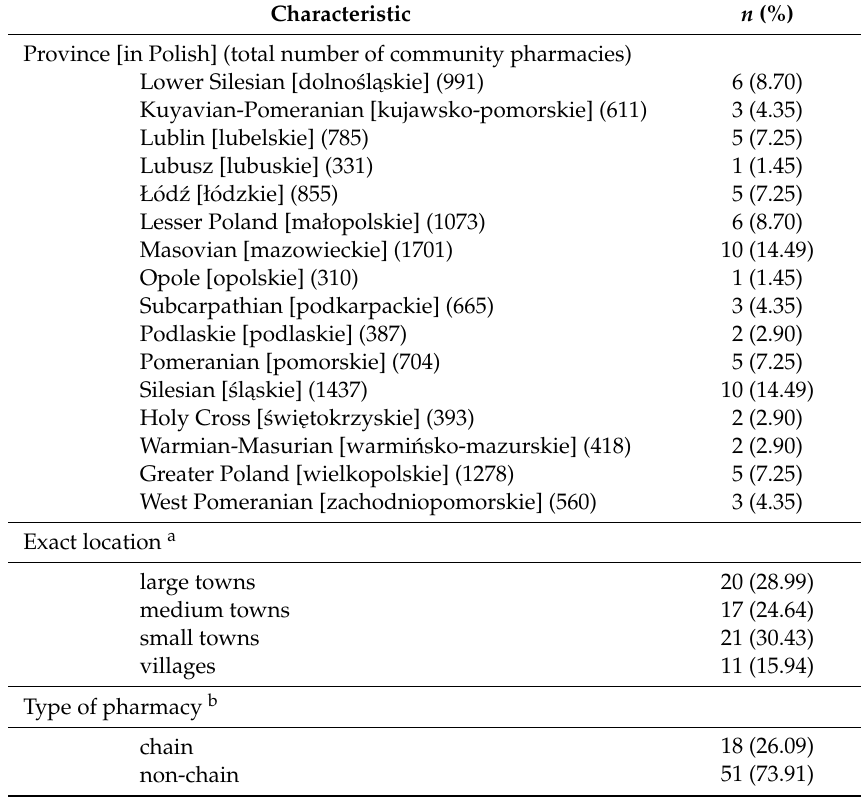
Figure 1. The scheme of consultation scenario which served as a guide for “mystery shopper” consultation. Table 1. Characteristics of randomly chosen community